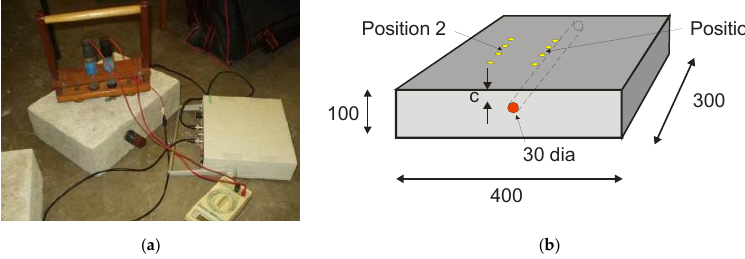
Figure 3. Scheme of ( a ) DC resistivity equipment on reinforced concrete specimen and ( b ) resistivity measurement locations on concrete specimen [19].